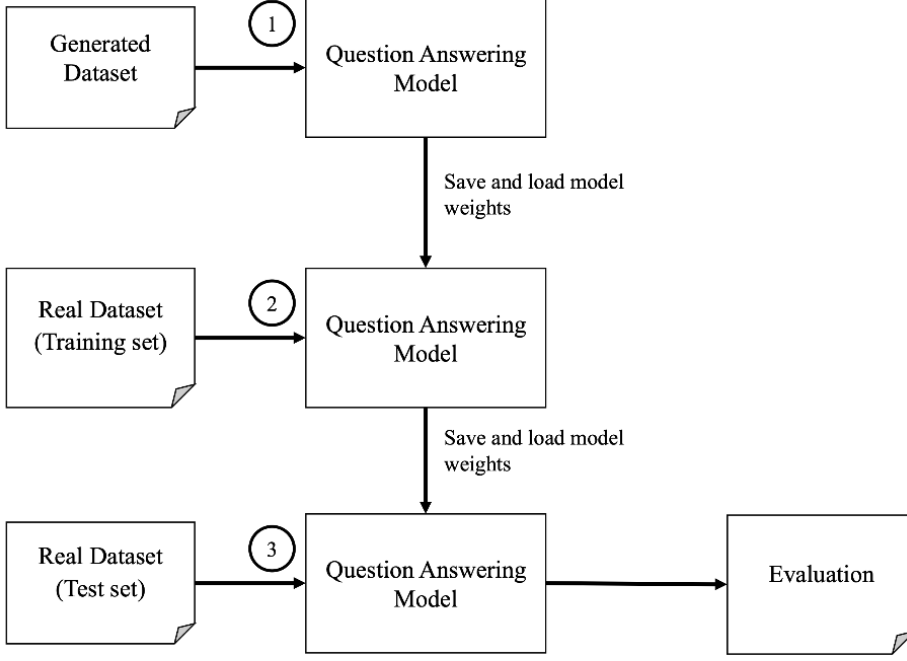
Figure 8. Illustration of the training flow of the Sequence Strategy. The other training strategy is Merge Strategy, which merges the generated data and the real training data, and fine-tunes at the same time, as illustrated in Figure